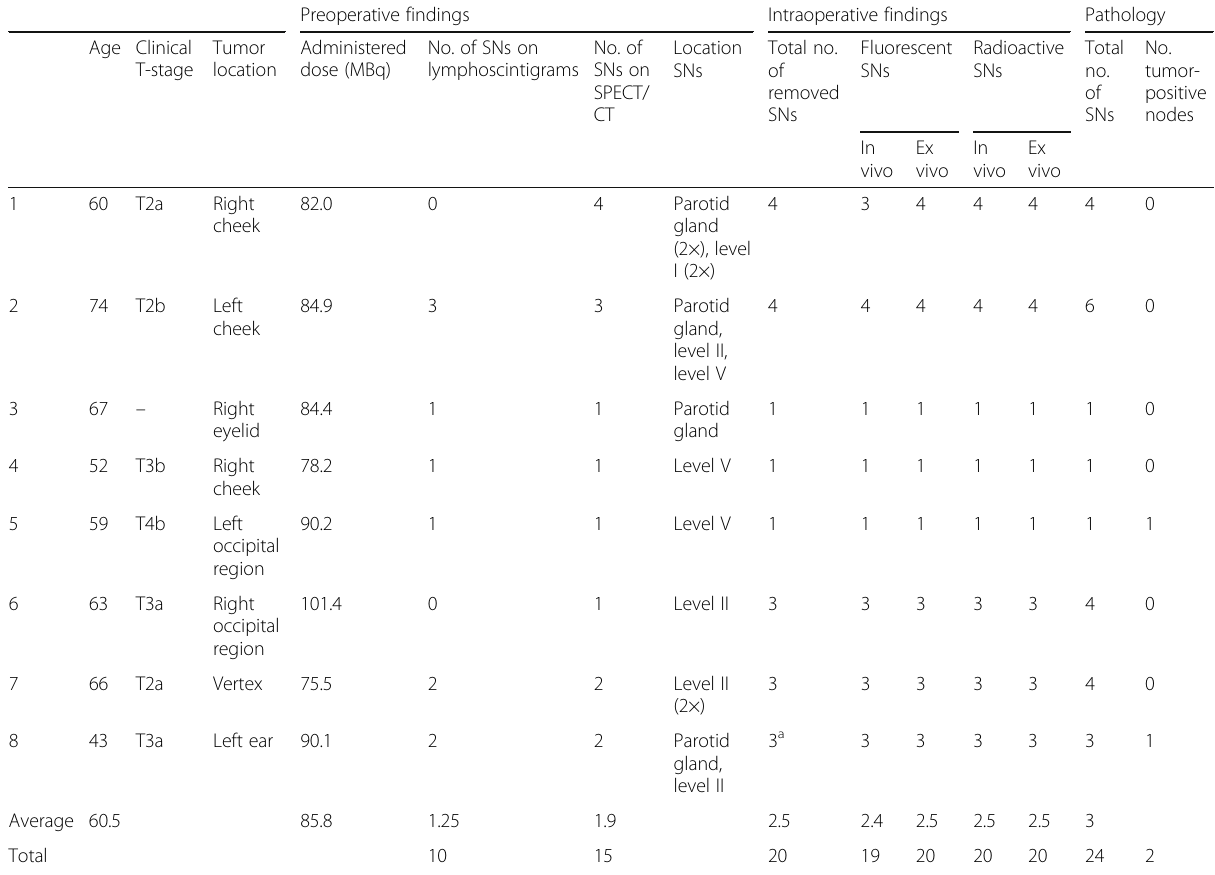
Table 1 Patient characteristics, preoperative and intraoperative findings, and pathology Preoperative findings Age Clinical Tumor Administered T-stage location dose